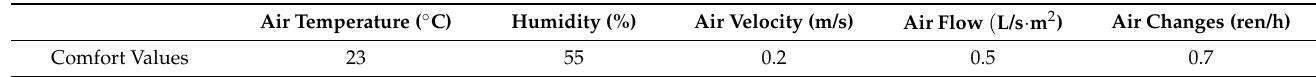
Table 6. Comfort values